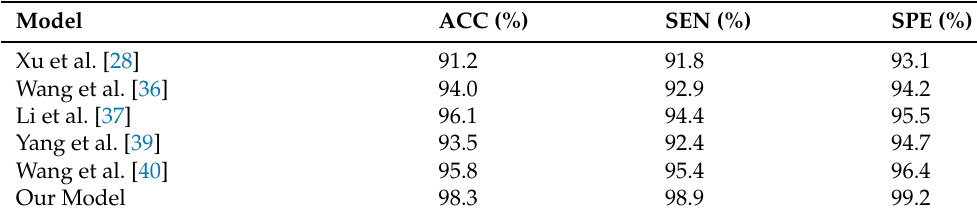
Table 7. Results obtained on our dataset using different pretrained models on our proposed model.